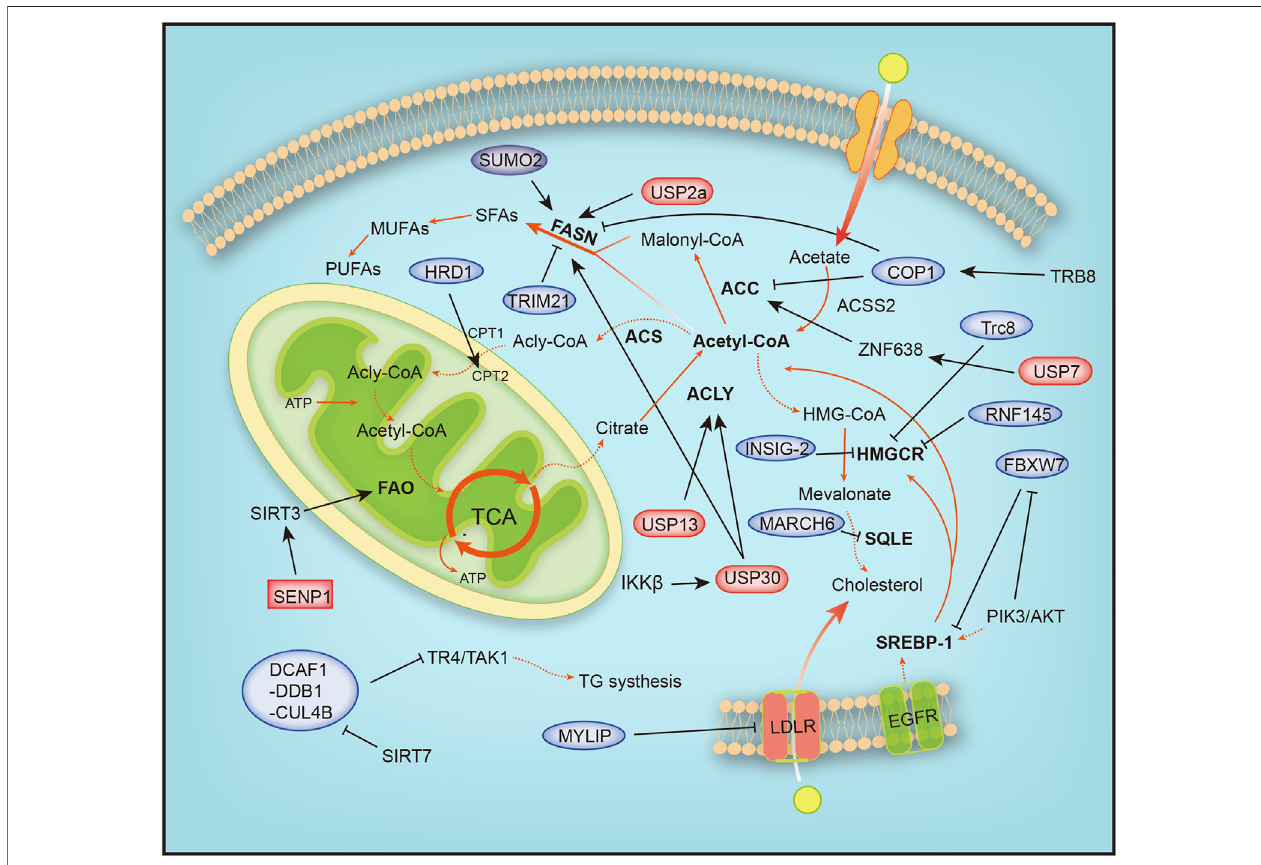
FIGURE 4 | Overview of the mechanisms by which ubiquitination and SUMOylation regulate lipometabolism. ACC, acetyl-CoA carboxylase; ACLY, ATP citrate lyase; ACS, acyl-CoA synthetase; ACSS2, acyl-CoA synthetase short-chain family member 2; ATP, adenosine triphosphate; COP1, constitutive photomorphogenic protein 1; CPT1, carnitine palmitoyl-transferase1; CPT2, carnitine palmitoyl-transferase 2; DCAF1-DDB1-CUL4B, DDB1-CUL4-associated factor 1 (DCAF1)/damage- speci fi c DNA binding protein 1 (DDB1)/cullin 4B; EGFR, epidermal growth factor receptor; FAO, fatty acid oxidation; FASN, fatty acid synthase; HMG-CoA, 3- hydroxy-3-methylglutaryl-coenzyme A; HMGCR, 3-hydroxy-3-methylglutaryl-coenzyme A reductase; HRD1, HMG-CoA reductase degradation protein 1; INSIG-2, insulin-induced gene 2; LDLR, low-density lipoprotein receptor; MARCH6, membrane-associated RING-CH 6; MUFA, monounsaturated FA; MYLIP, myosin regulatory light chain-interacting protein; PIK3, phosphoinositide-3-kinase; PUFA, polyunsaturated FA; RNF145, ring fi nger protein 145; SENP1, SUMO-speci fi c protease 1; SFA, saturated FA; SIRT1, silent information regulator 1; SIRT3, silent information regulator 3; SQLE, squalene epoxidase; SREBP1/2, sterol regulatory element-binding protein 1/2; SUMO2, small ubiquitin-like modi fi er 2; TCA, tricarboxylic acid cycle; TR4/TAK1, testicular nuclear receptor 4; Trc8, translocation in renal carcinoma chromosome 8 gene; Trim 21, tripartite motif 21; USP13, ubiquitin speci fi c protease 13; USP2a, ubiquitin speci fi c protease 2a; USP30, ubiquitin speci fi c protease 30, USP7, ubiquitin speci fi c protease 7; ZNF638, zinc fi nger protein 638.